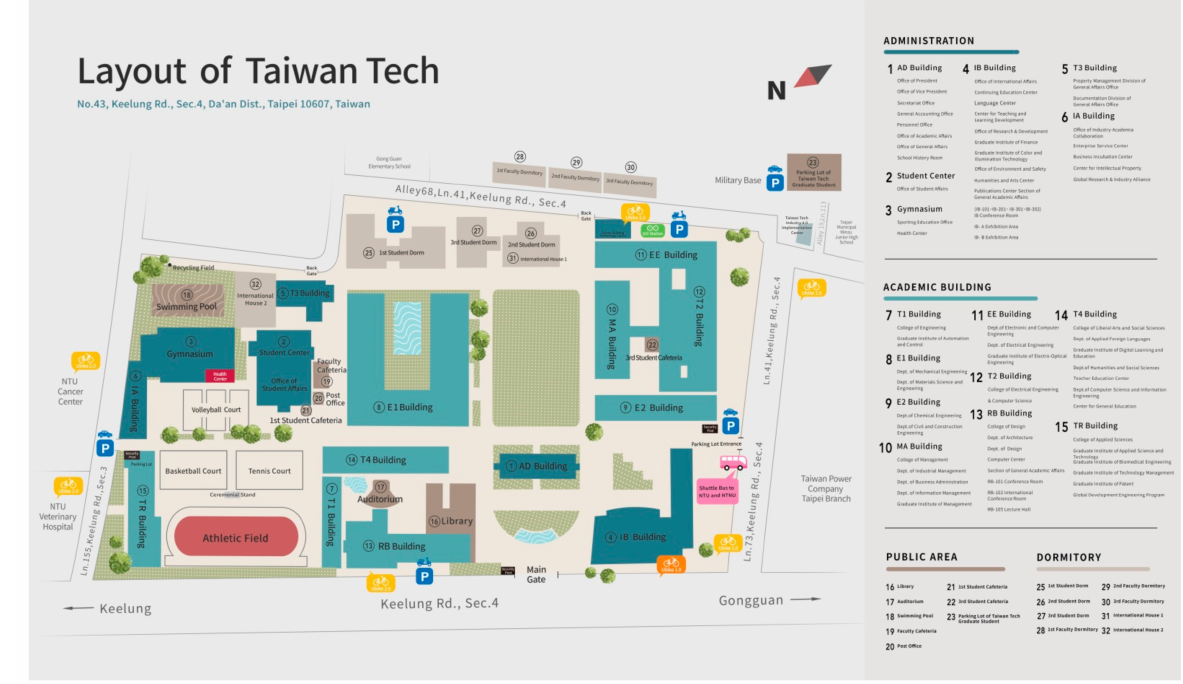
Figure 1. Main campus map of Taiwan